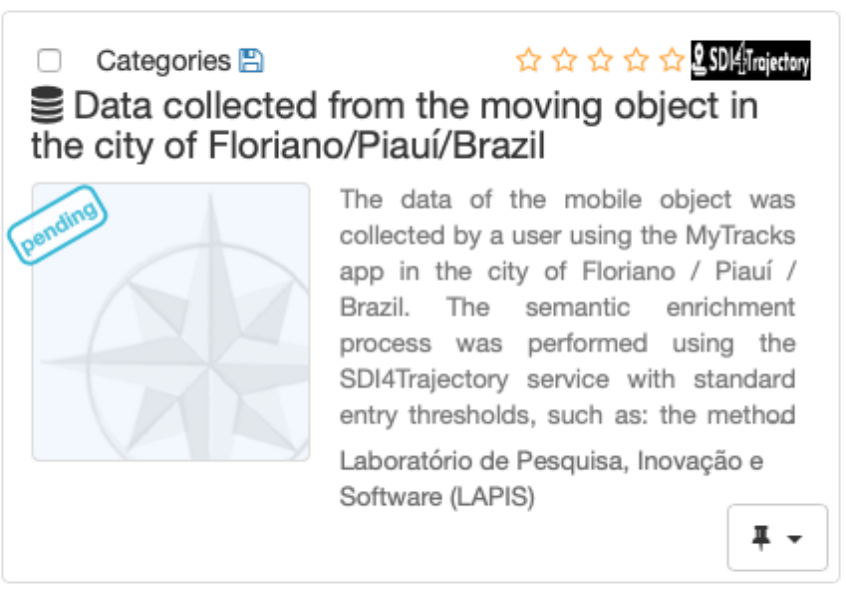
Figure 12. Example of STMO documentation in the metadata